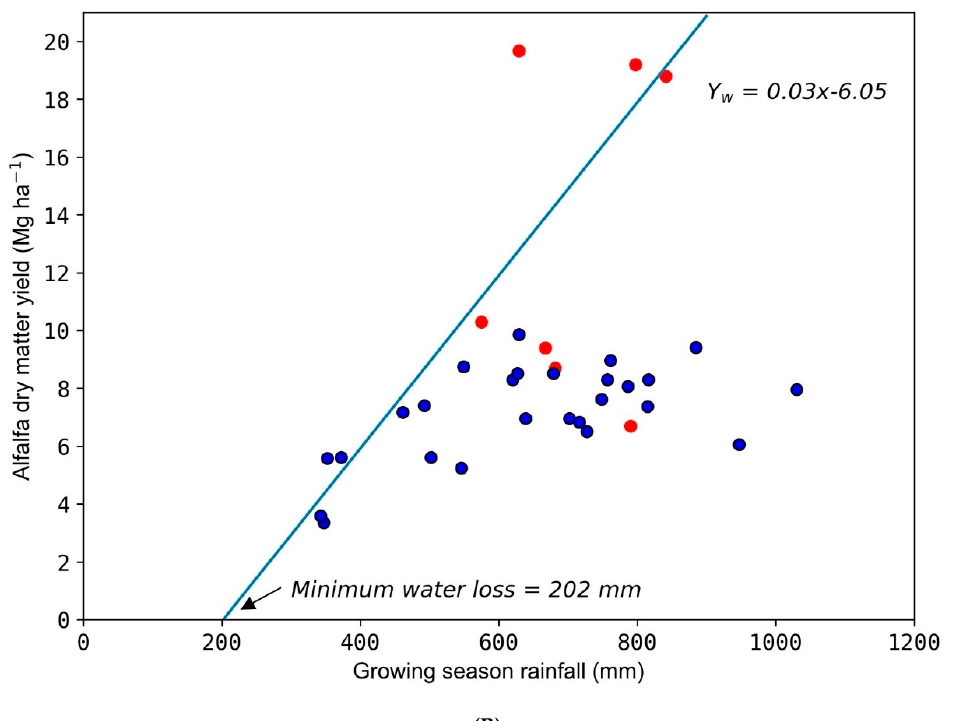
Figure 3. Example of attainable yield ( Ya ) estimated using frontier yield function model (A), and water-limited potential yield ( Yw ) (B) using linear boundary function model for McPherson County, Kansas. The Y c in (A) represents the farmers reported mean yield of past 30 years. The maximum value of the frontier line at the y -axis in (A) represents Ya and the corresponding value at the x -axis represents the optimum growing season rainfall. The blue dots represent the annual alfalfa dry matter yield of the 26-yr period (1988–2013) for that county. The red circled dots represent maximum yield ever recorded for that county within a certain rainfall range during the 26-yr period. The slope of a linear line in (B) represents water use efficiency and the value at which the linear line intersects the x -axis represents the minimum water loss from soil. The equation developed in (B) estimates Yw . The red dots are the yield data obtained from research experiment conducted in Riley, Finney, and Thomas Counties, Kansas during the study period.